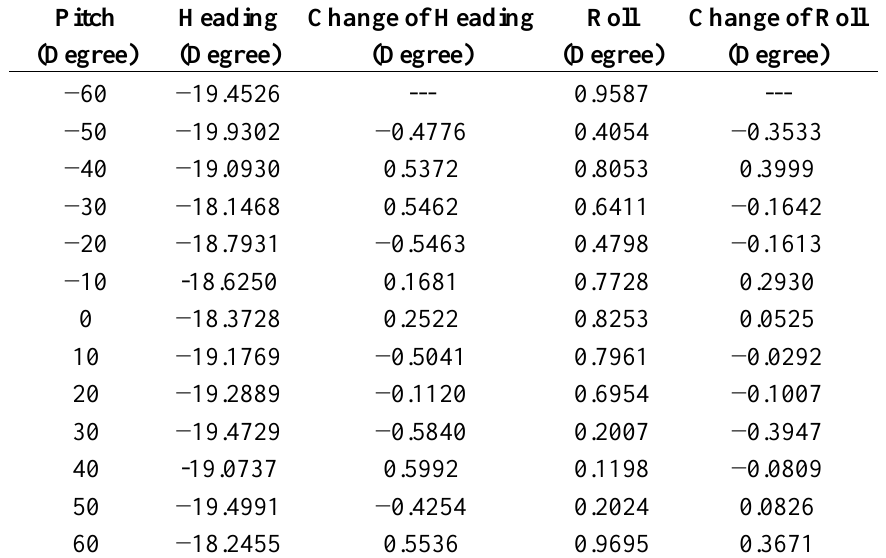
Table 7. The outputs of heading and roll while pitch is changing (using backing